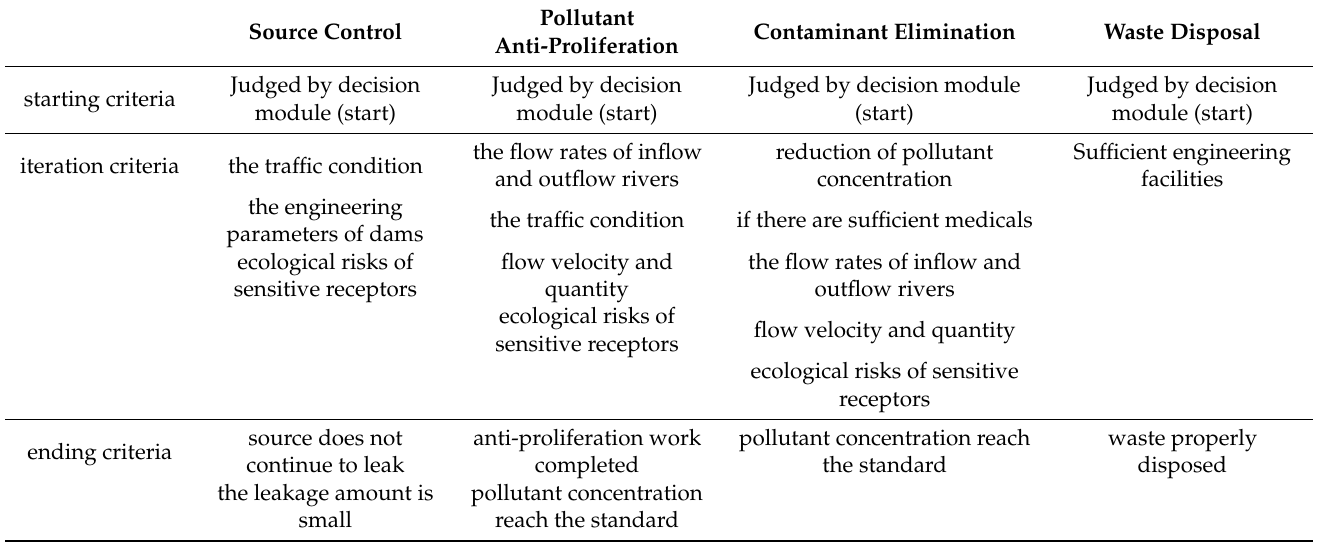
Table 3. Judgment assist index system for iteration and ending of each